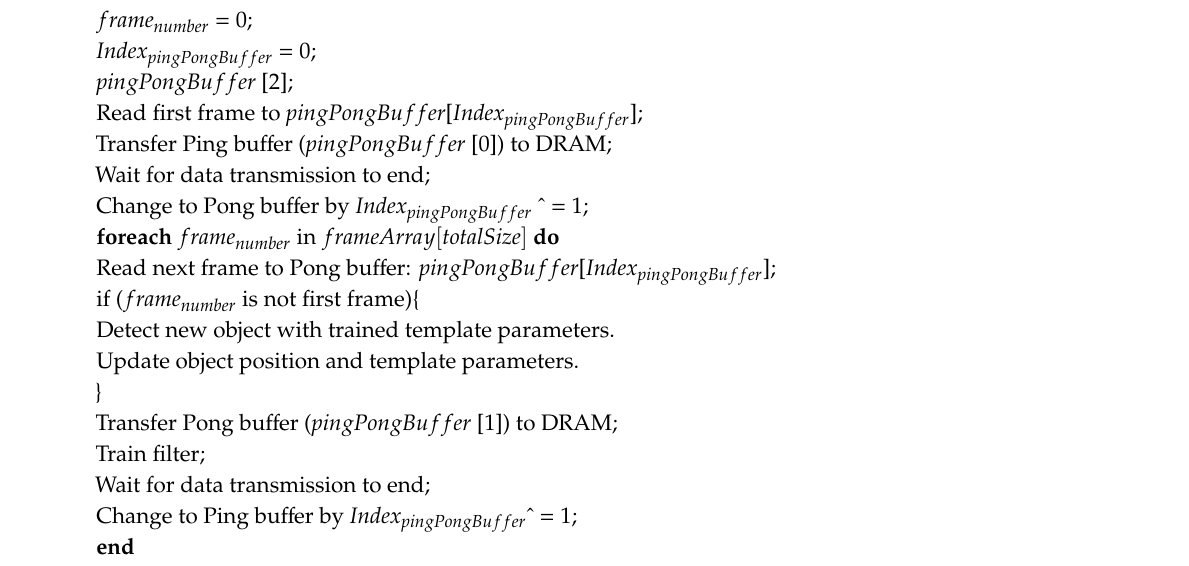
Algorithm 1. Pseudo-code for migration of the data by iDMA during object